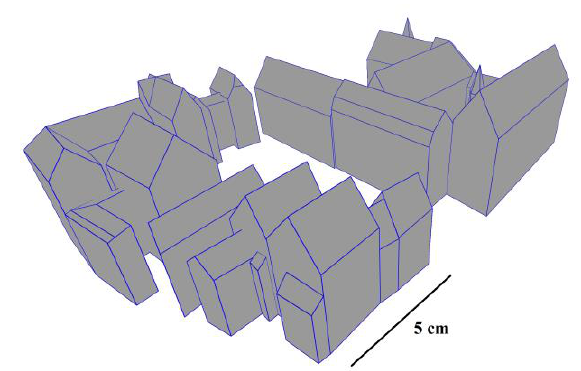
Figure 10. Result of the parametric modelling for city block